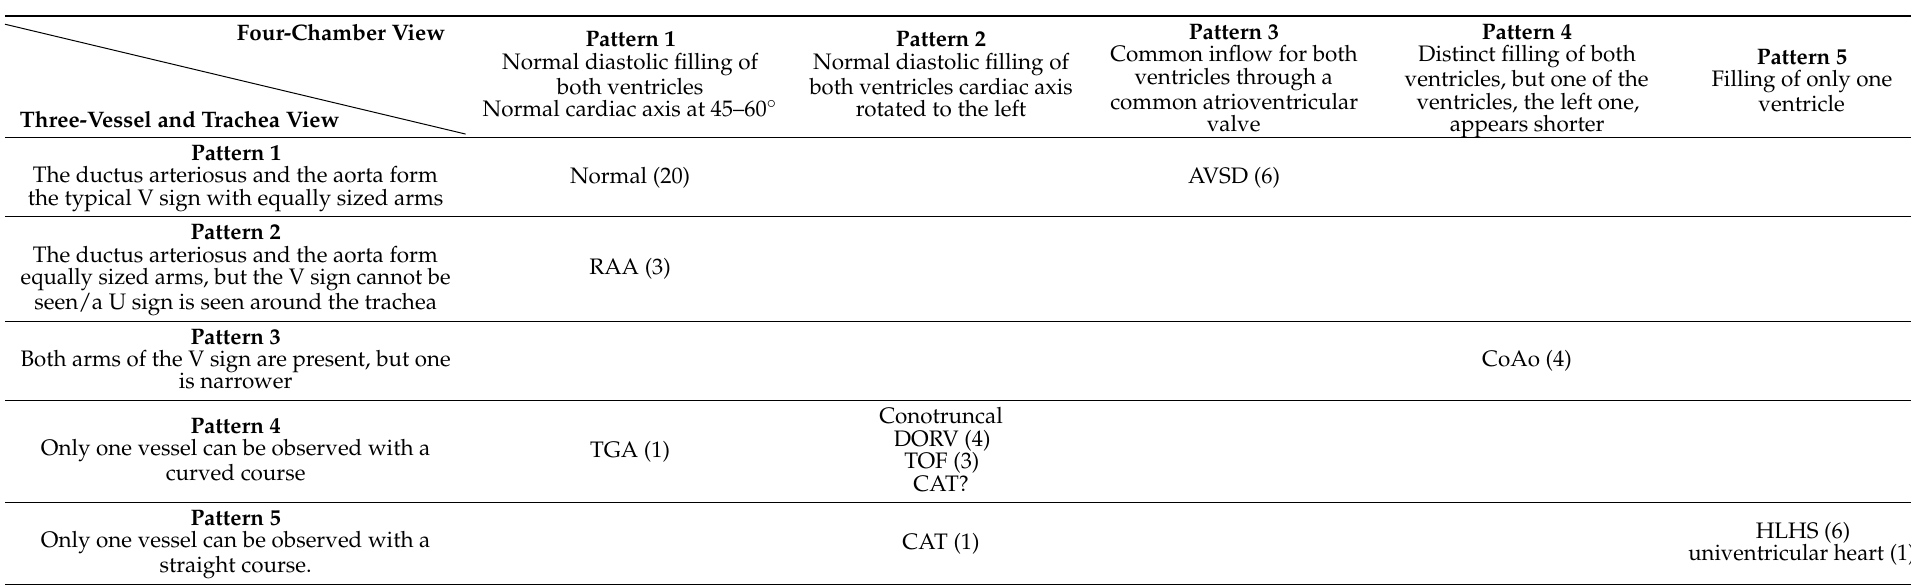
Table 2. Color flow patterns seen in the four-chamber and the three-vessel and trachea views in normal and abnormal